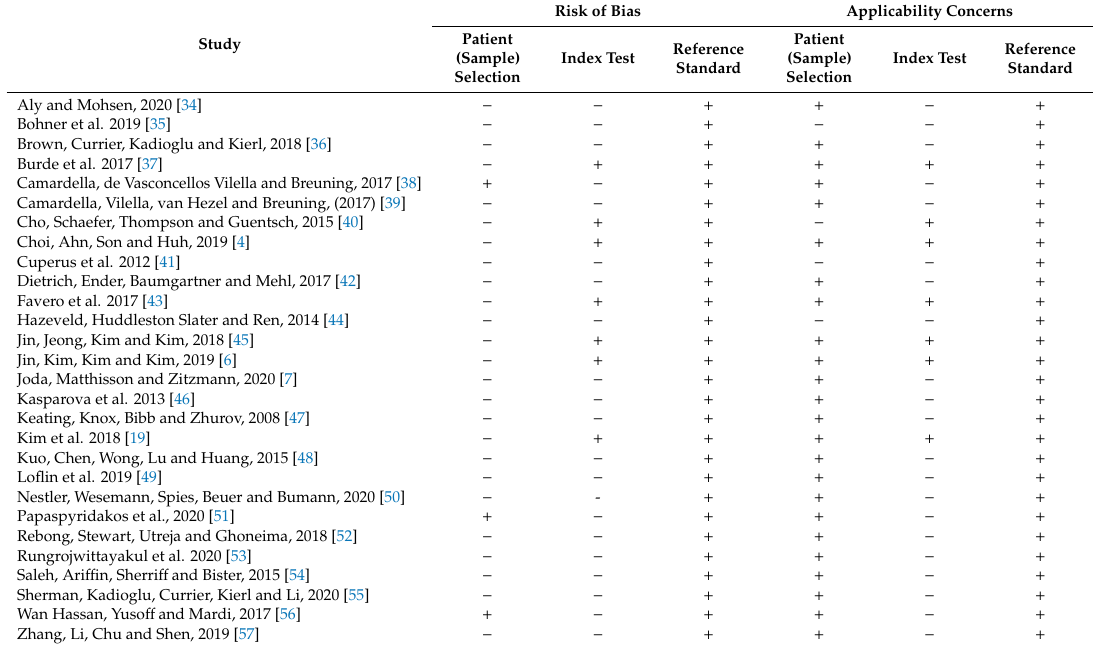
Table 3. Risk of bias and applicability concerns according to QUADAS-2 tool. Negative sign (–) denotes high risk of bias. Positive sign ( + ) denotes low risk of